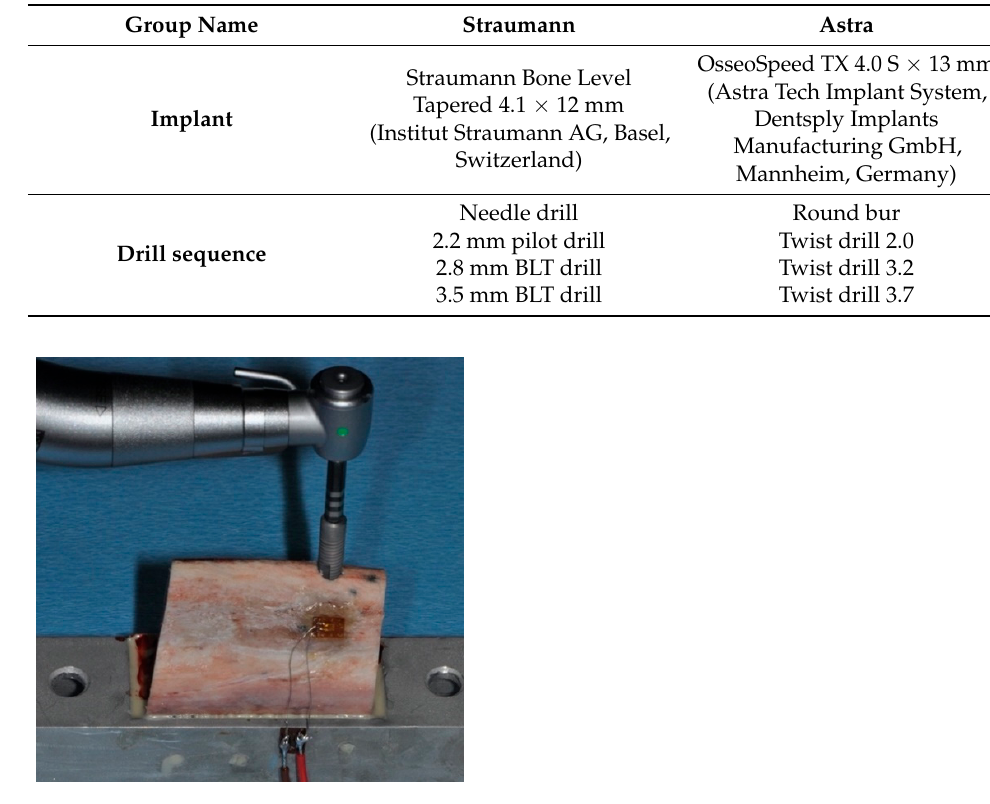
Table 1. Implant types and drill protocols.